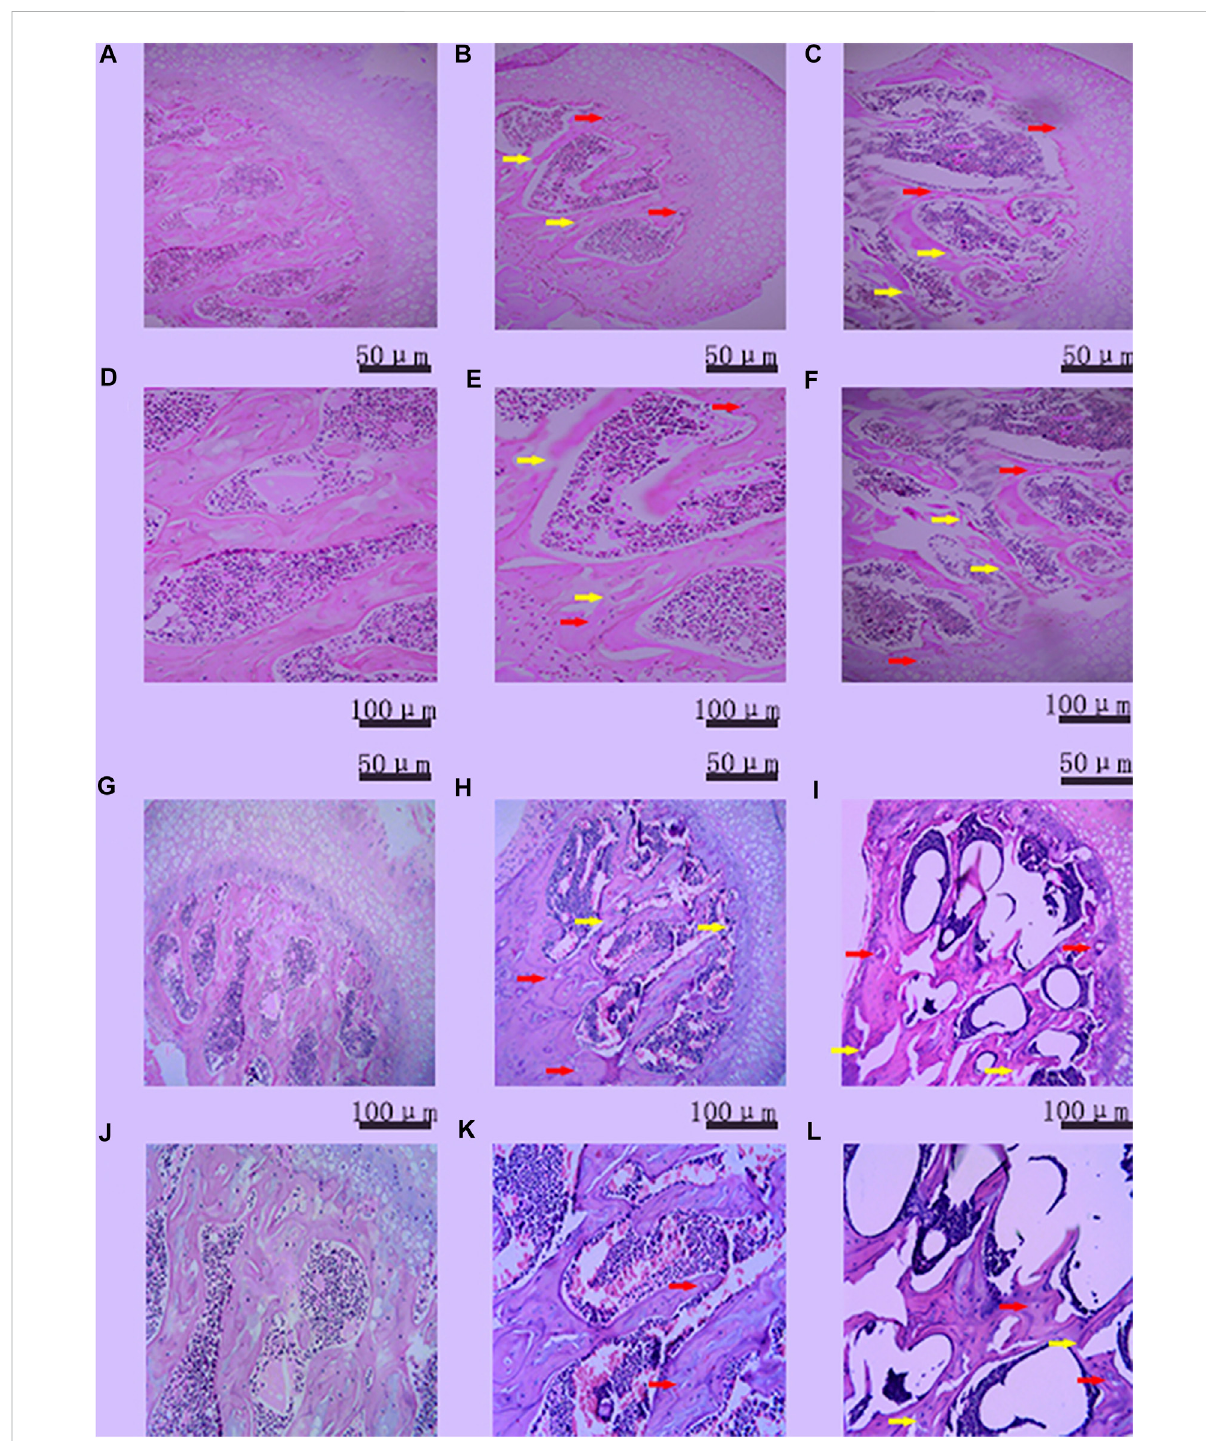
FIGURE 4 Histopathologicalanalysis of empty bone lacunae in the femoral head in the 4th (A – F) week and the 8th (G – L) week in the control group [ (A) (100X), (D) (200X); (G) (100X), and (J) (200X)], DA group [ (B) (100X), (E) (200X); (H) (100X), and (K) (200X)] and DAA group [ (C) (100X), (F) (200X), (I) (100X),and (L) (200X)].Emptybonelacunae(theredarrow)andtrabecularfractures(theyellowarrow)wereevidentinthefemoralheadsofthethree groups, demonstrating that the mouse model of femoral head osteonecrosis was successfully